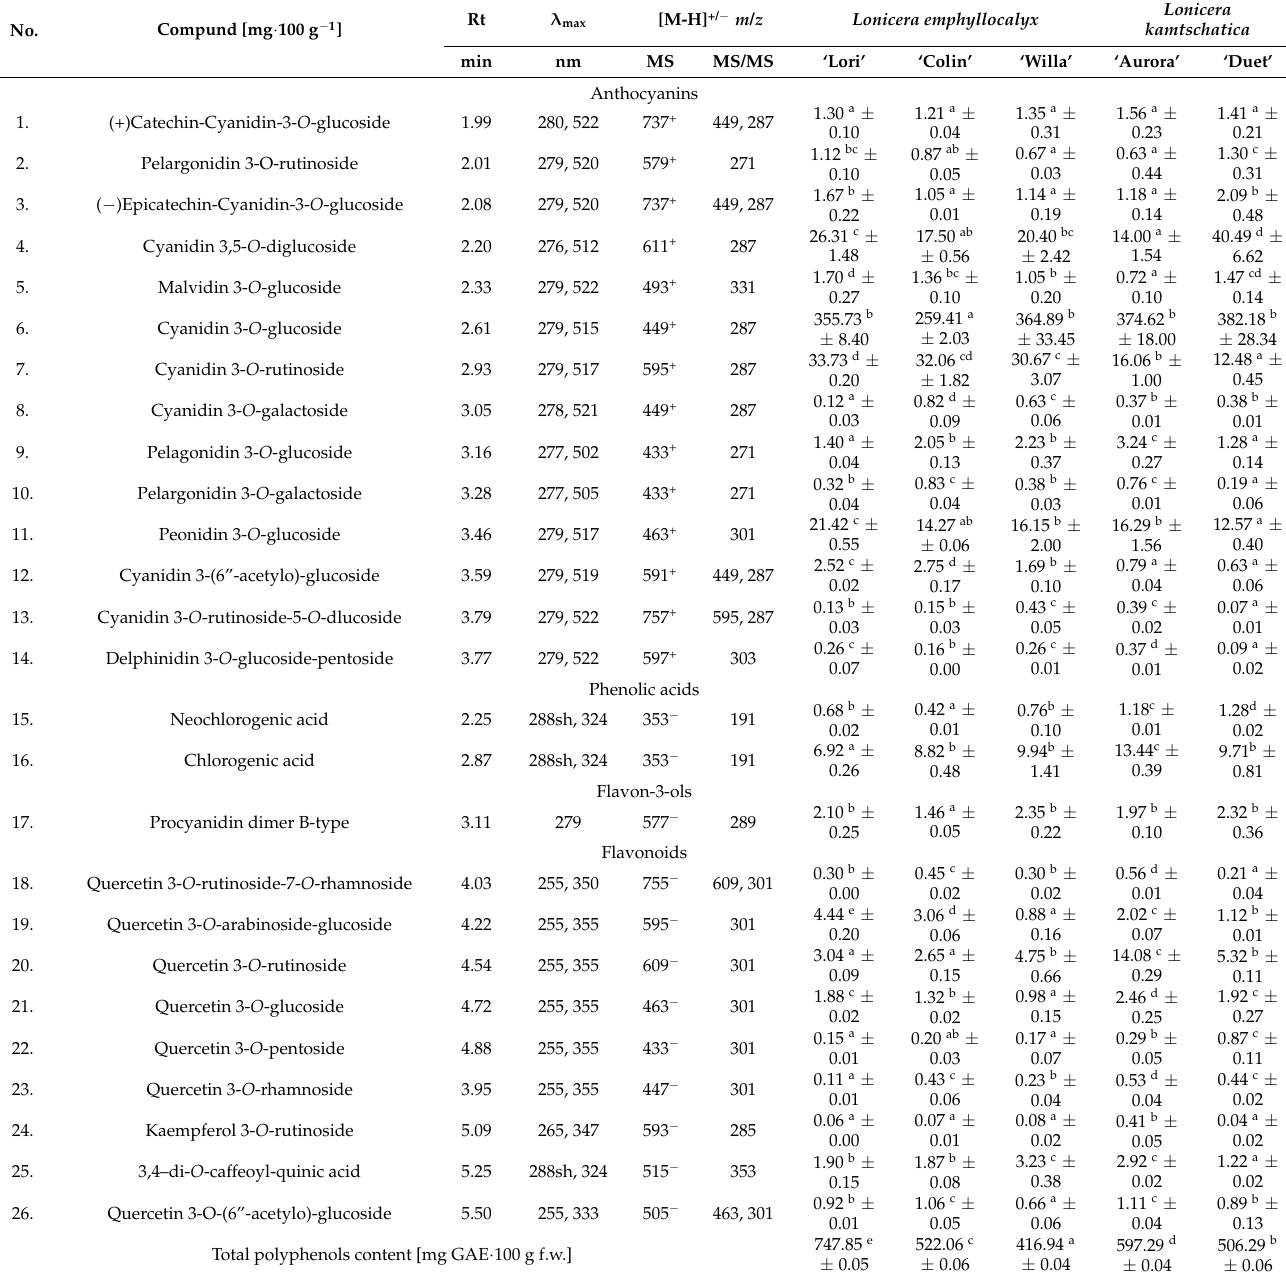
Table 2. Individual phenolic compounds identified by UPLC-PDA-MS/MS in L . kamtschatica i L. emphyllocalyx